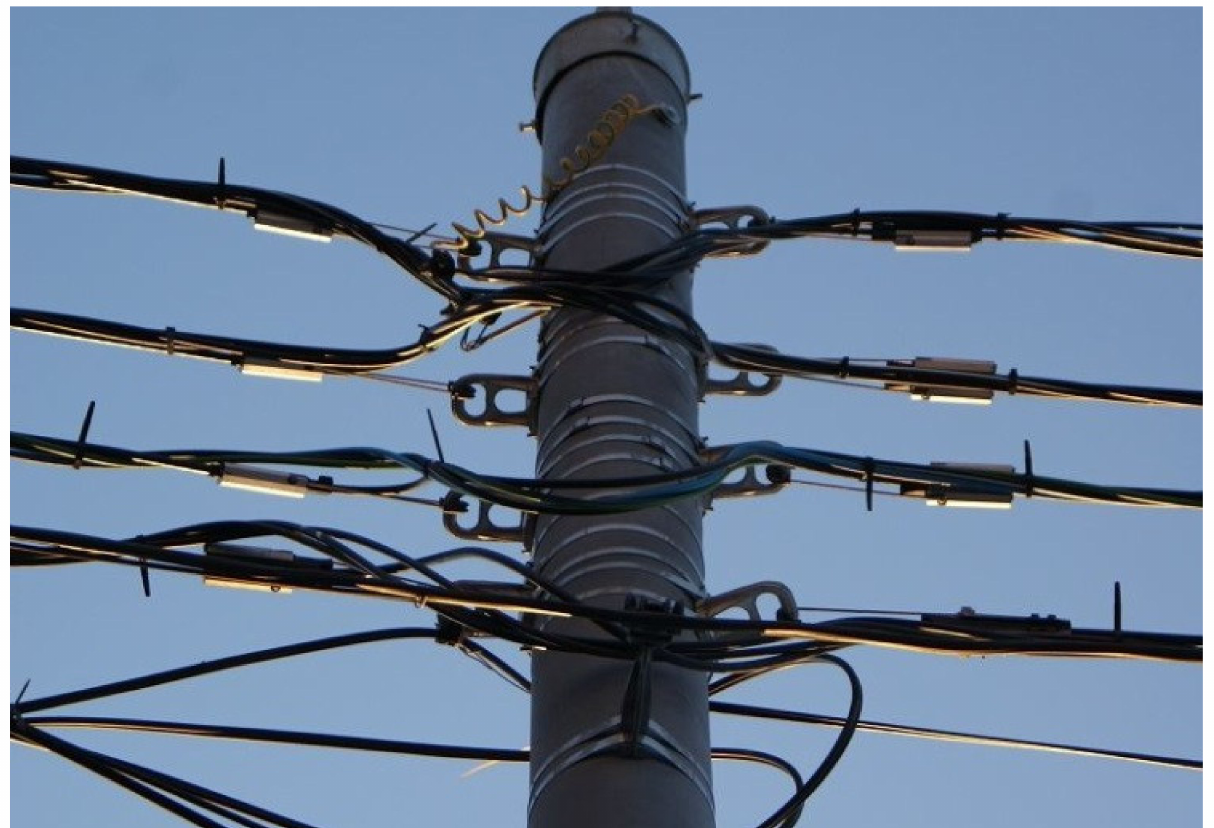
Figure 4. Four-circuit overhead line with insulated